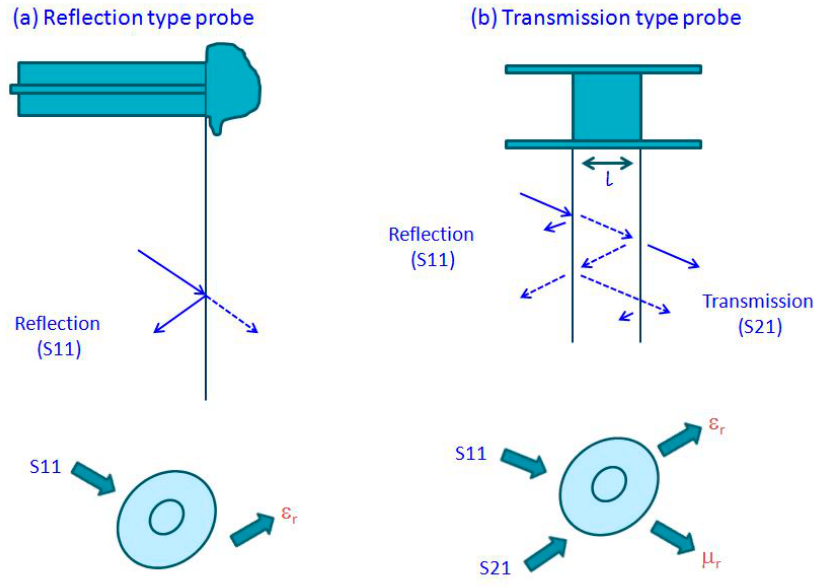
Figure 4. Reflection types of the probe ( a ); and transmission types of the probe ( b ).